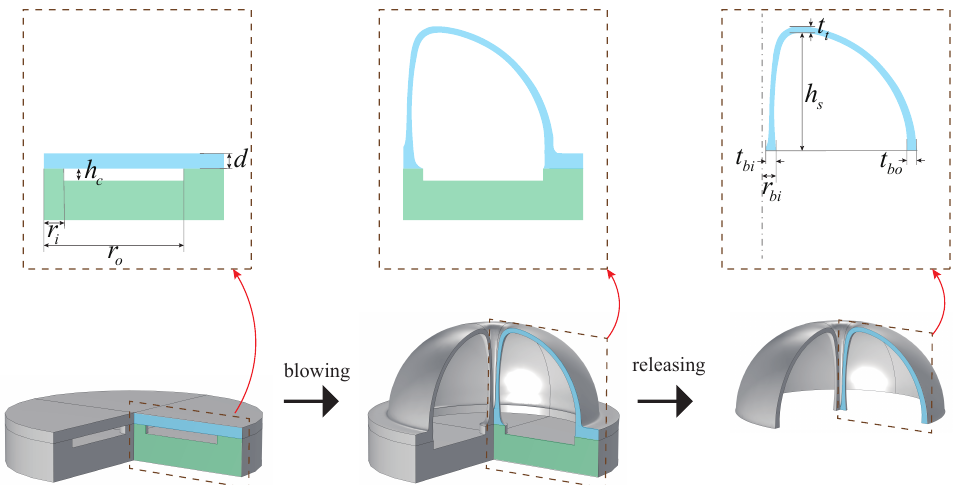
Figure 3. Microhemispherical shell-forming process and key structural parameters before and after forming.